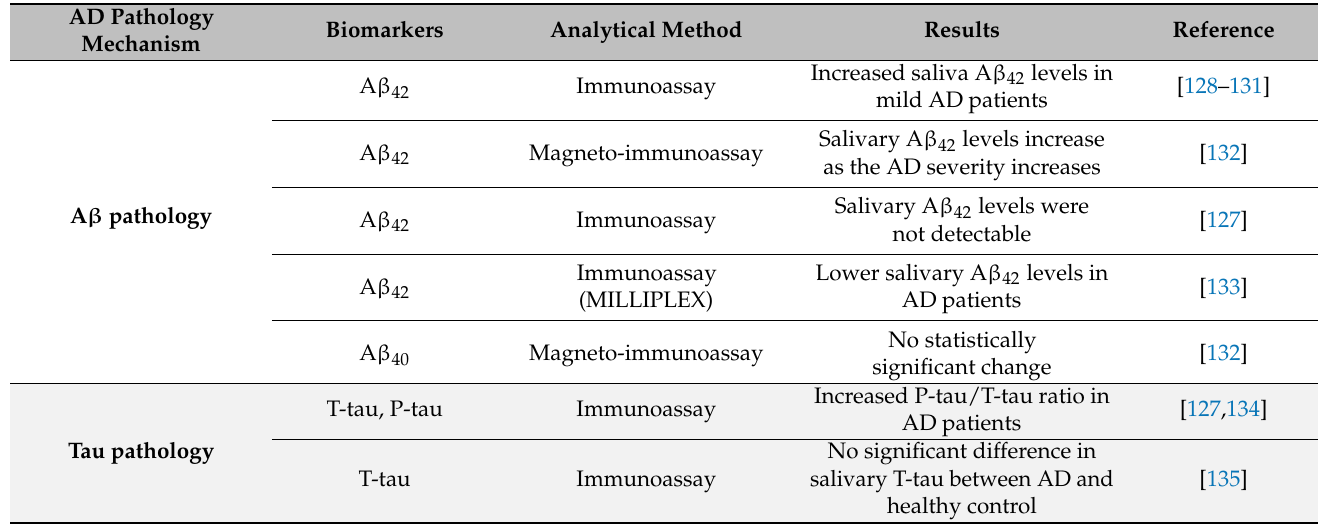
Table 9. Summary of core AD biomarkers in